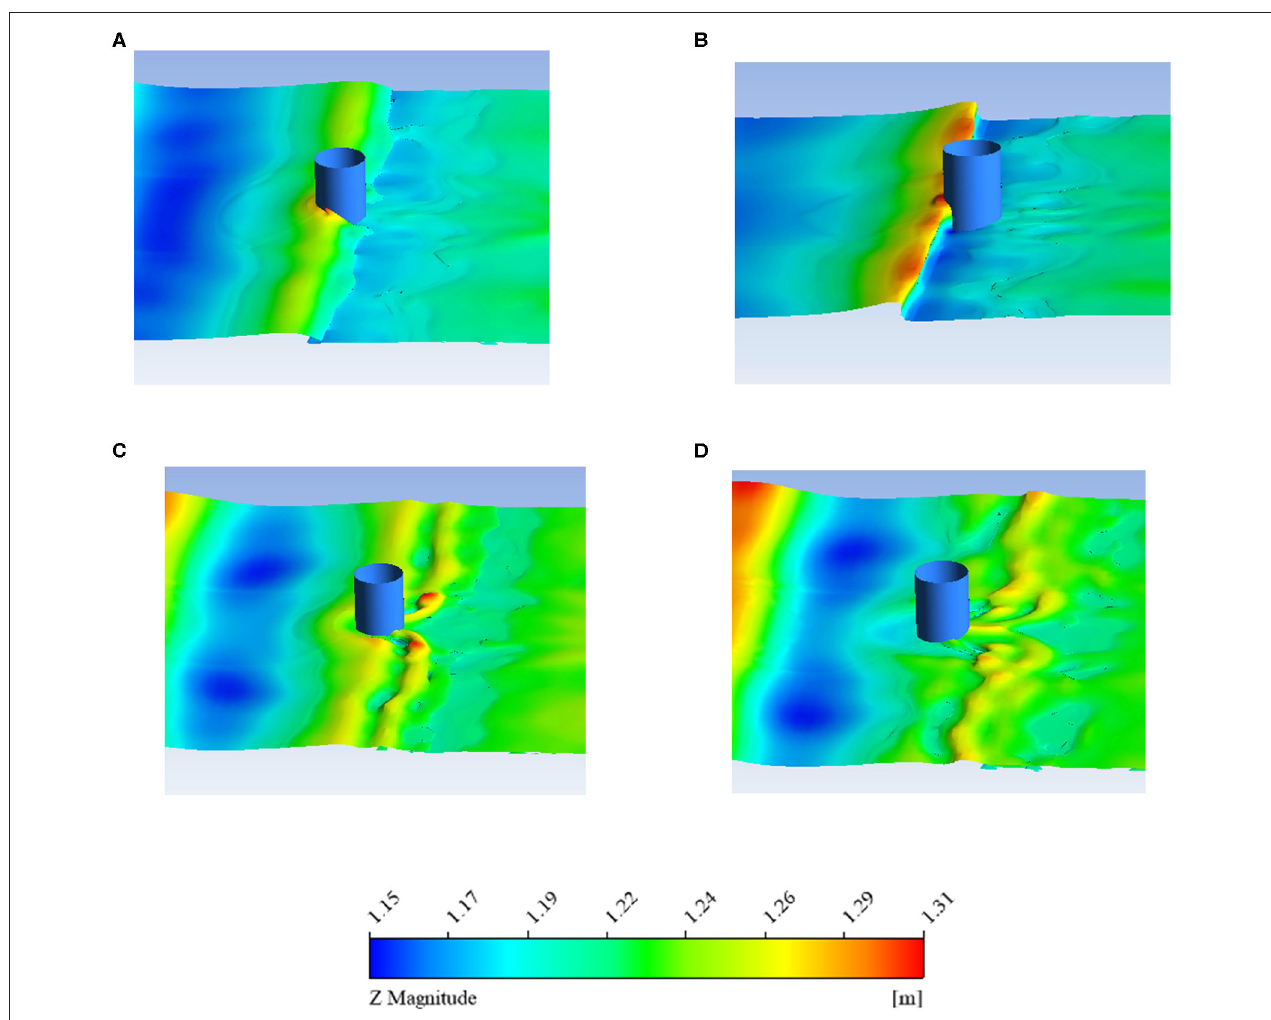
FIGURE 9 | Breaking waves ( ξ 0 = 1.000) flow around the monopile foundation. (A) time = 12.24s; (B) time = 12.4s; (C) time = 12.56s; (D) time =